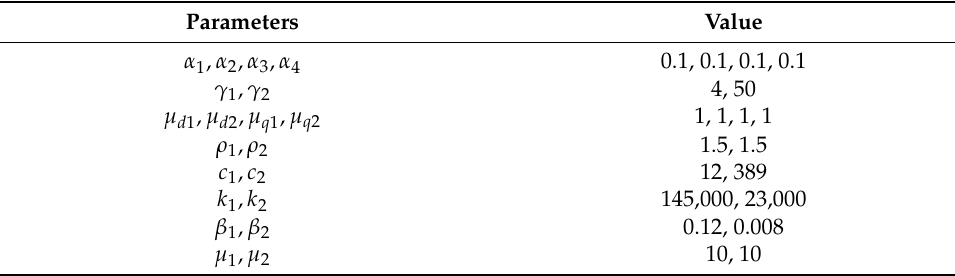
Table 2. Controller